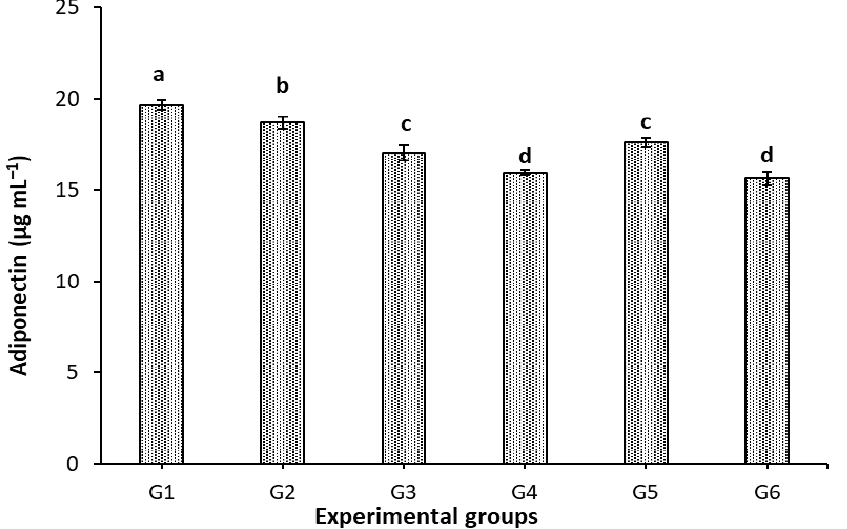
Figure 2. Effect of IF, FCM, and FCM-D on leptin and adiponectin levels in obese rats fed a high-fat diet for 6 weeks, n = 8; G1-G6: experimental groups see materials and methods, Section 2.3; a,b,c,d : bars not sharing similar letters are significantly different ( p > 0.05). ( A ): Leptin level (ng mL − 1 ) and ( B ): Adiponectin ( µ g mL − 1 ).